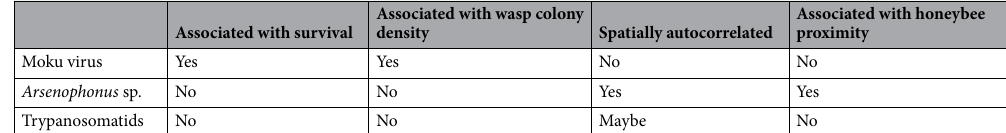
Table 3. Summary of associations between pathogens and colony survival, density and spatial distribution.